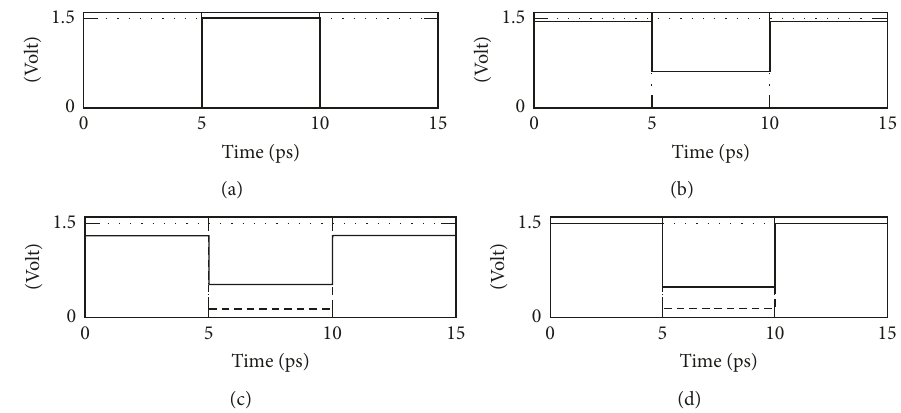
Figure 12: Input and output waveforms of inverter: (a) input data. Output data obtained by (b) SE-LUT models, (c) FBE model, and (d) TSB model.